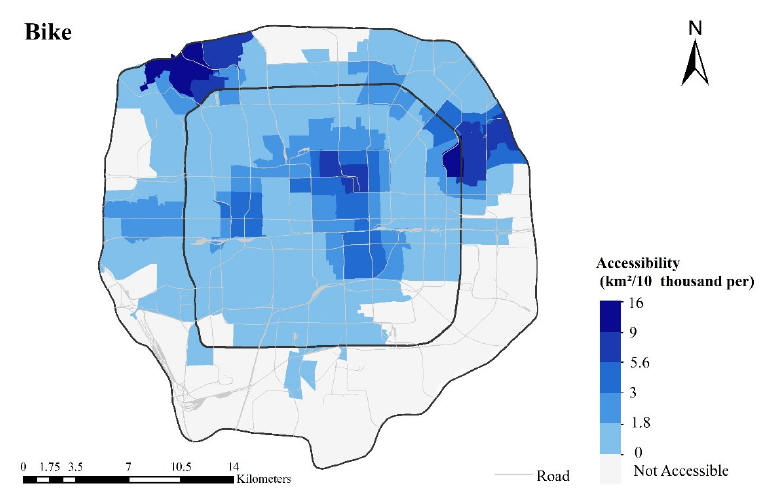
Figure 7. The accessibility results of walking.